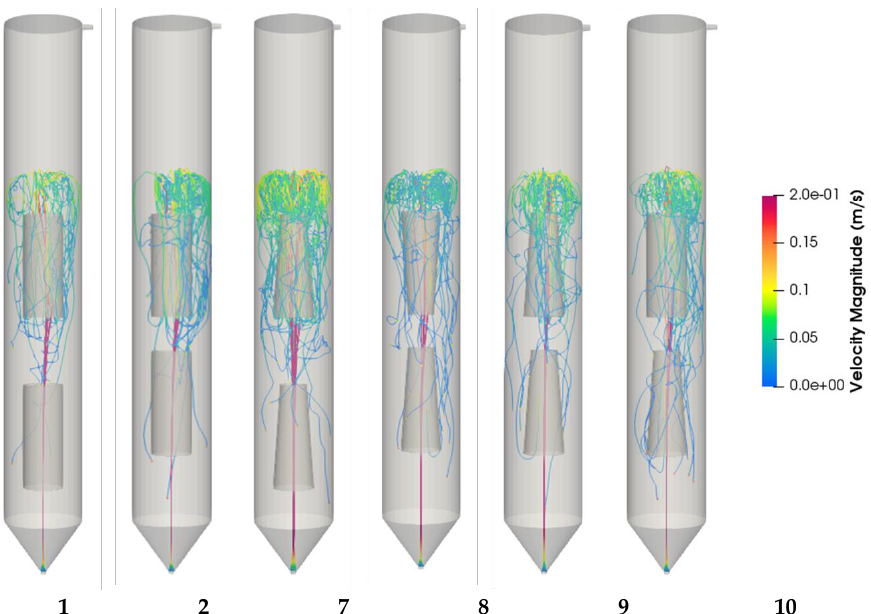
Figure 13. Streamlines coloring the velocity magnitude of a sample of 25 particles representing the flow field inside of geometries 1, 2, 7, 8, 9 and 10.